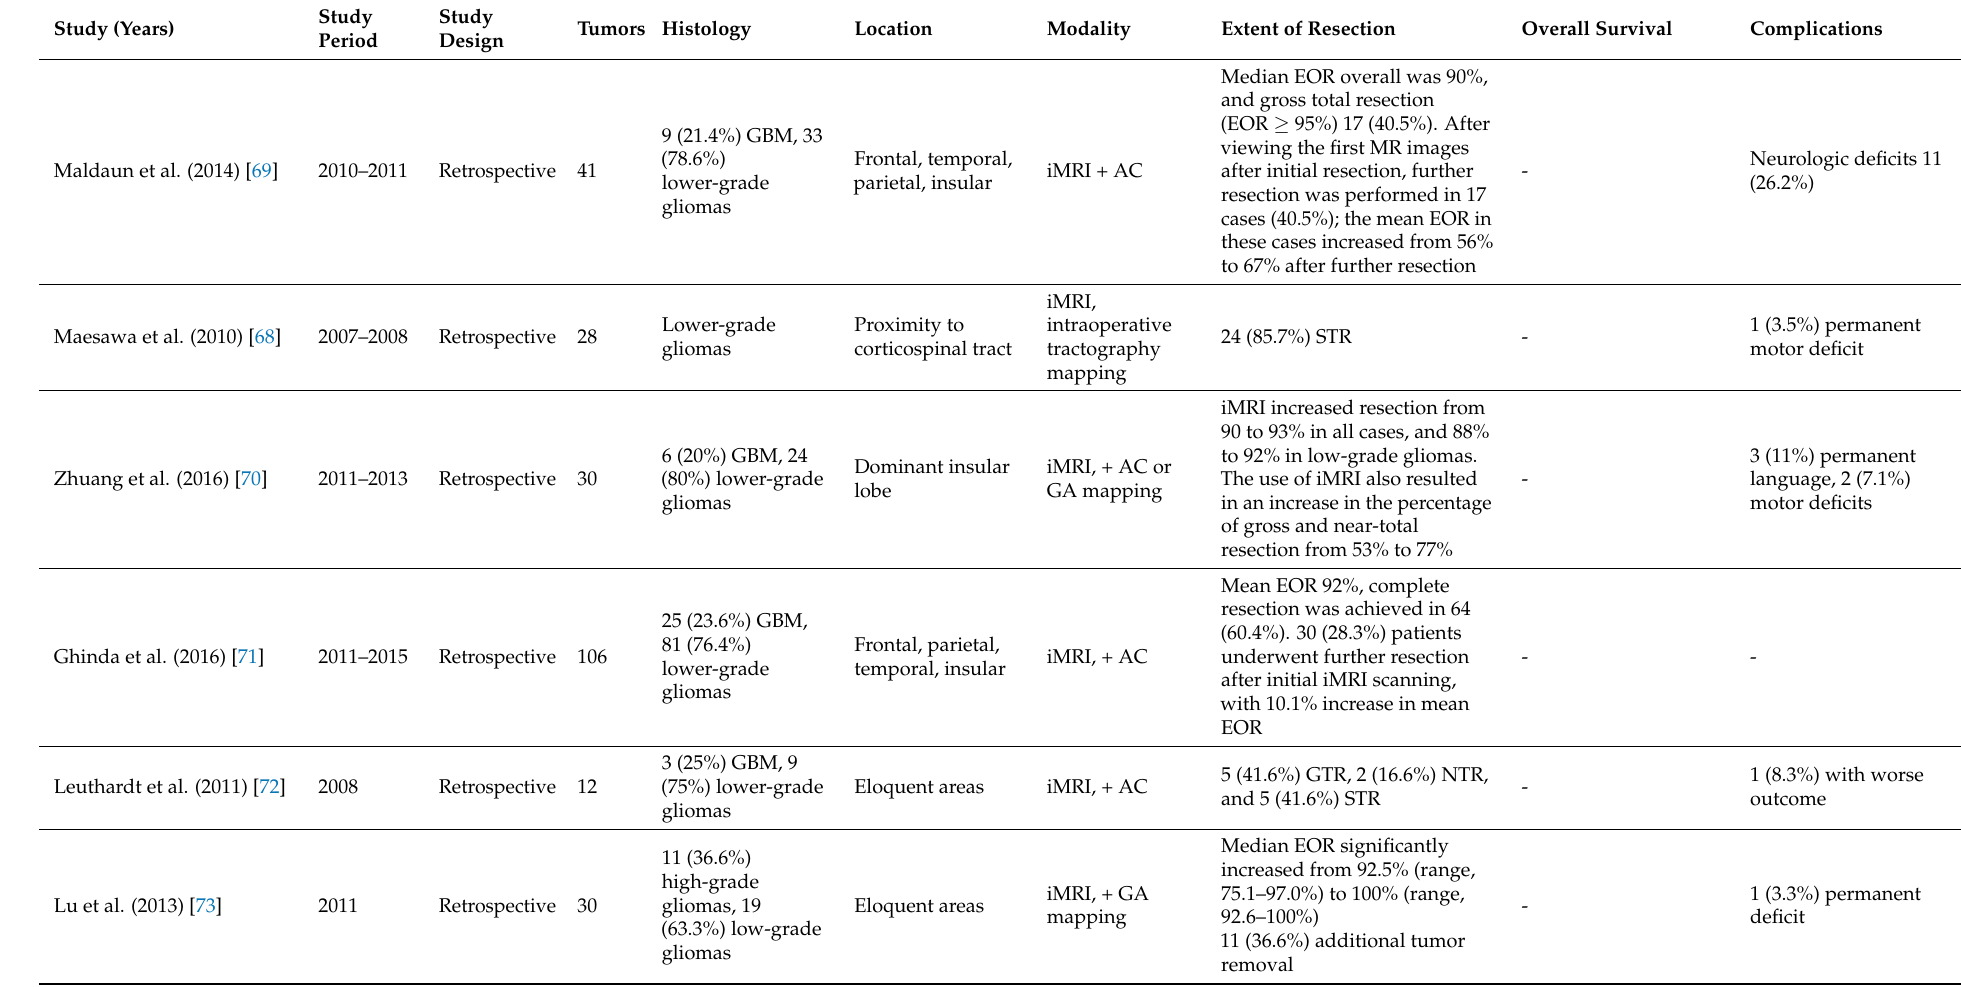
Table 4. Studies investigating combined intraoperative modalities in improving the extent of